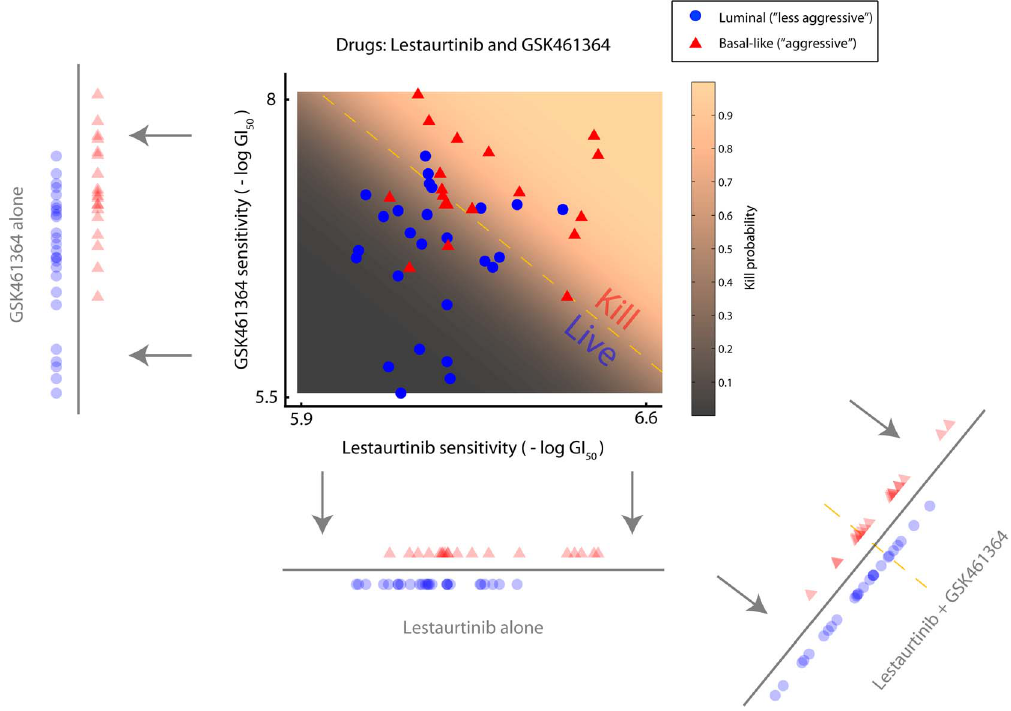
Figure 7. Cancer treatment optimization. Better discrimination between cell populations is achieved by including an additional drug. The classification threshold line shown, in reality, represents a gradient related to ‘‘probability of cell death’’ which is indicated by shading. See text for full description.